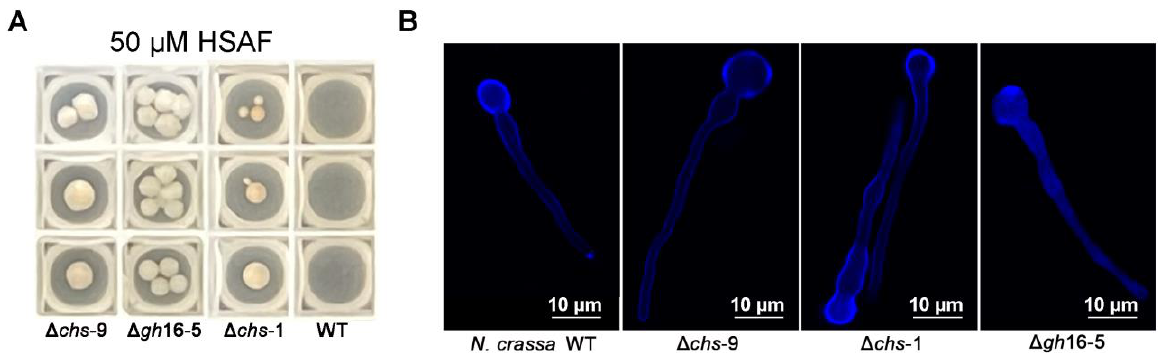
Figure 4. Deletion of gene chs-9 , gh16-5, or chs-1 in N. crassa increased the HSAF resistance. ( A ) Growth phenotype of the indicated mutants and wildtype of N. crassa on Vogel ’s media with 50 µM HSAF; ( B ) CFW staining of cell wall of wildtype and the indicated mutants of N. crassa . Images show the results of one out of three replicates.